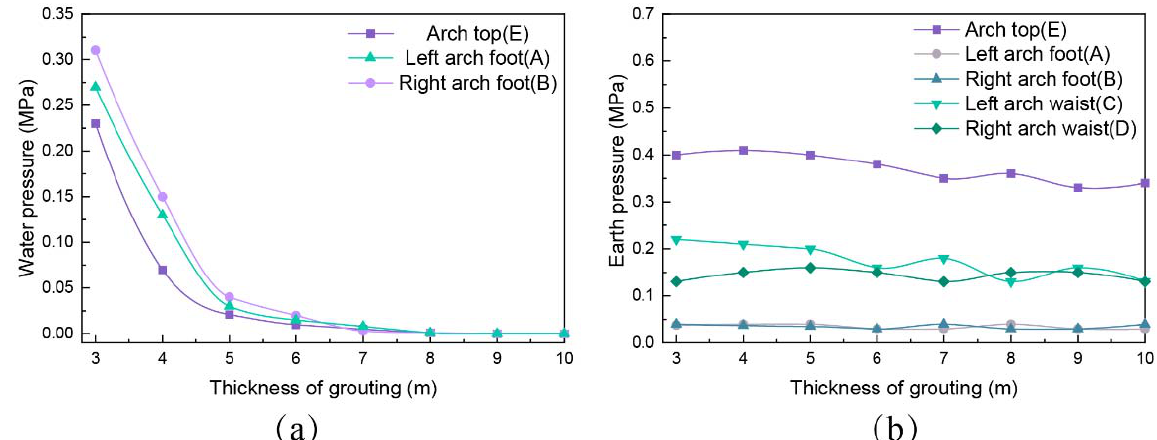
Figure 17. Trend of pressure with grout thickness at different locations in the numerical model: ( a ) characteristics of water pressure variation with grouting thickness; ( b ) characteristics of earth pressure variation with grouting thickness.